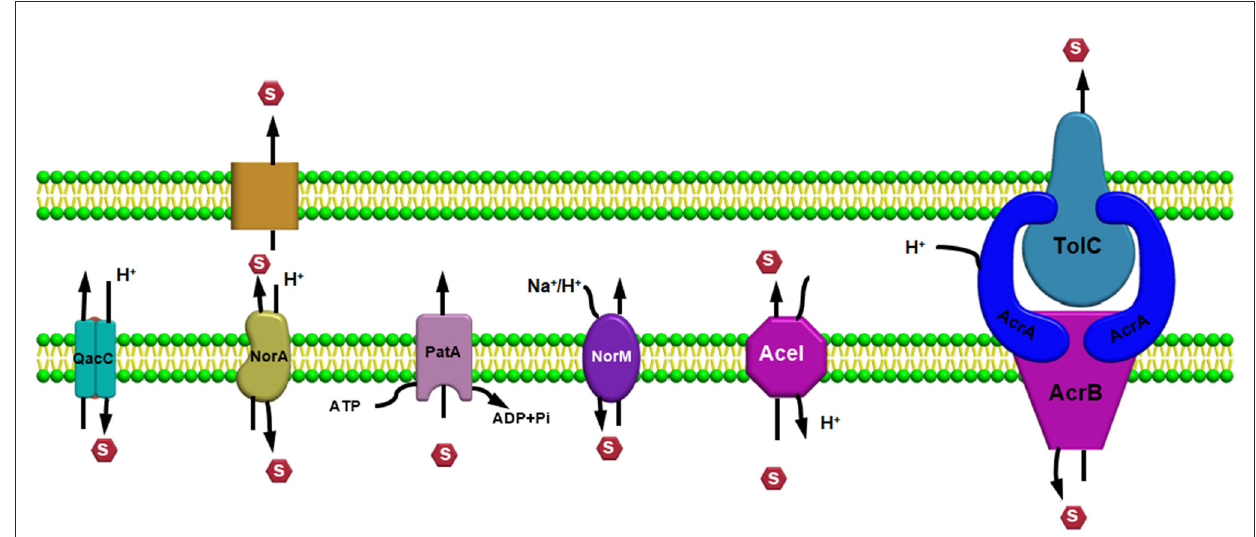
FIGURE1 Efflux pump major super-families based on their energy source utilized to export the substrates.